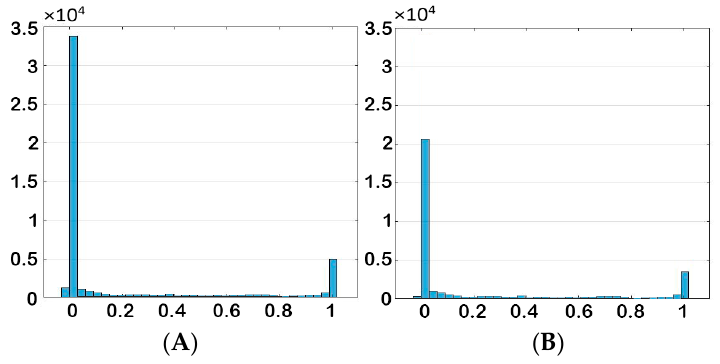
Figure 28. Histogram of phase fraction ( A ) before and ( B ) after elimination.